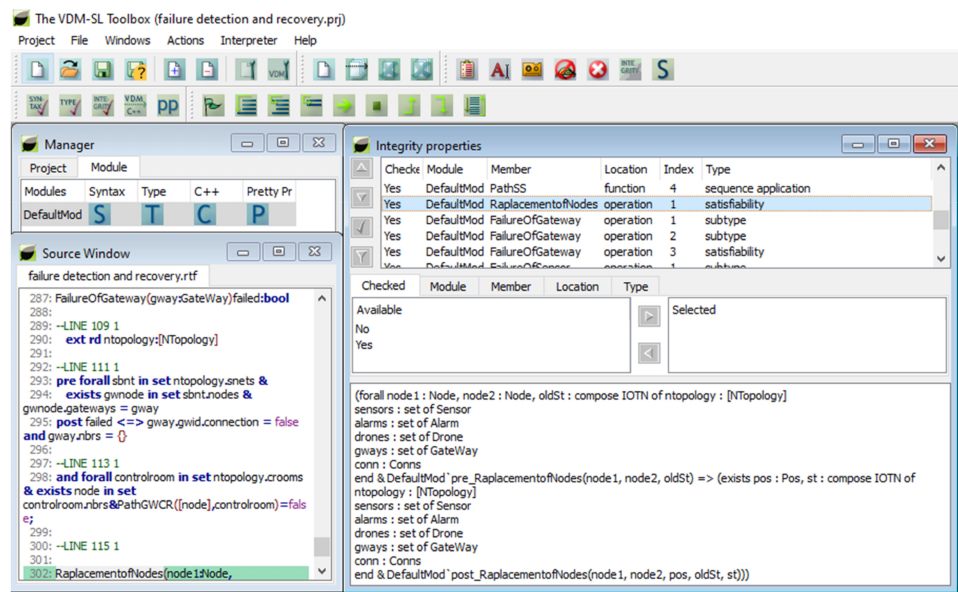
Figure 5. Proof of formal analysis for failure detection and recovery